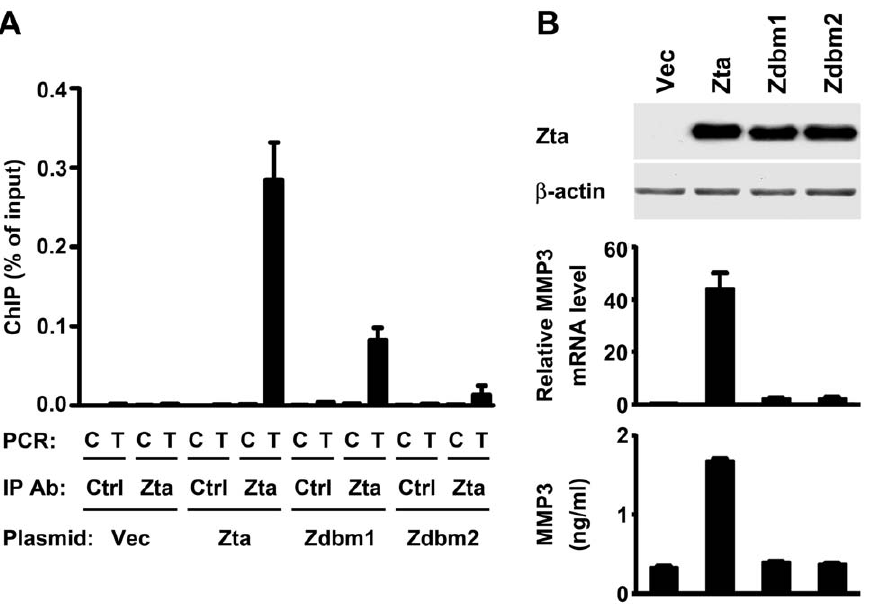
Figure 5. The DNA-binding domain of Zta is required for induction of MMP3 expression. ( A ) NPC cells were transfected with a vector plasmid (Vec) or plasmids expressing wild-type Zta or the DNA binding-defective mutants (Zdbm1 and Zdbm2) and then subjected to a ChIP assay. The antibodies used for immunoprecipitation (IP Ab) included an anti-Zta antibody and a control antibody (Ctrl). In the immunoprecipitants, the target DNA region (T) spanning AP-1 elements of the MMP3 promoter and the control DNA region (C) distant from the AP-1 elements were quantified by using real-time PCR. The ChIP results were expressed as ‘‘percentage of input’’. ( B ) Cells were transfected with a vector plasmid or plasmids expressing wild-type Zta, Zdbm1 or Zdbm2. Protein expression of Zta and b -actin was examined by an immunoblotting assay (upper panel). Expression levels of MMP3 mRNA were measured by quantitative RT-PCR (middle panel). Concentrations of MMP3 protein in the cell culture supernatants were quantified by using ELISA (lower